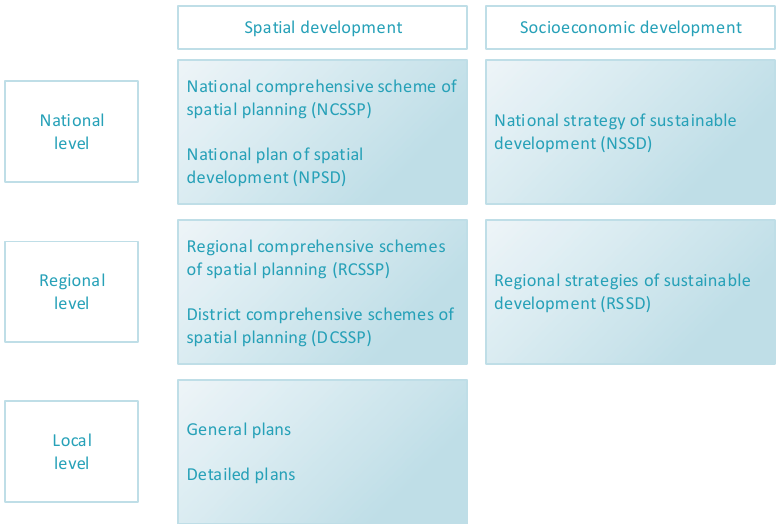
Figure 1. Belarus Planning System. Source: Own Work.